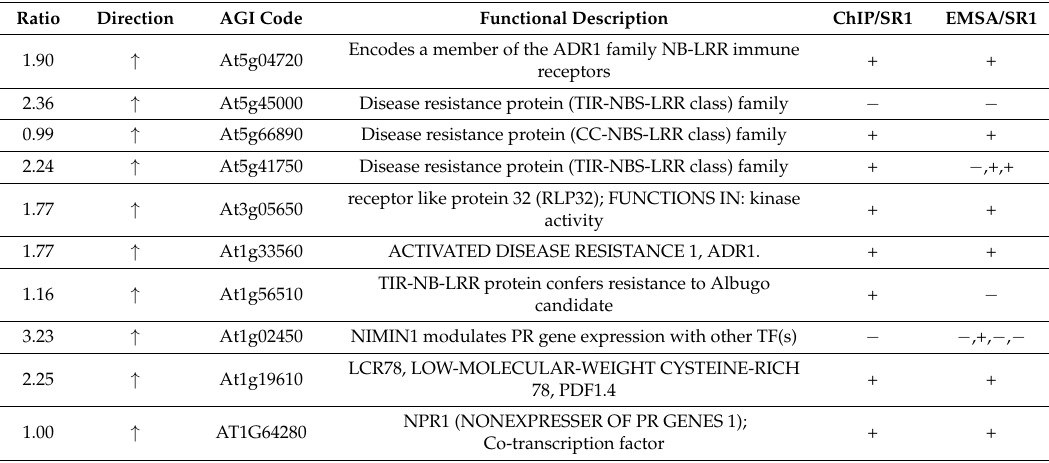
Table 1. Putative AtSR1 target genes related to plant immune response.